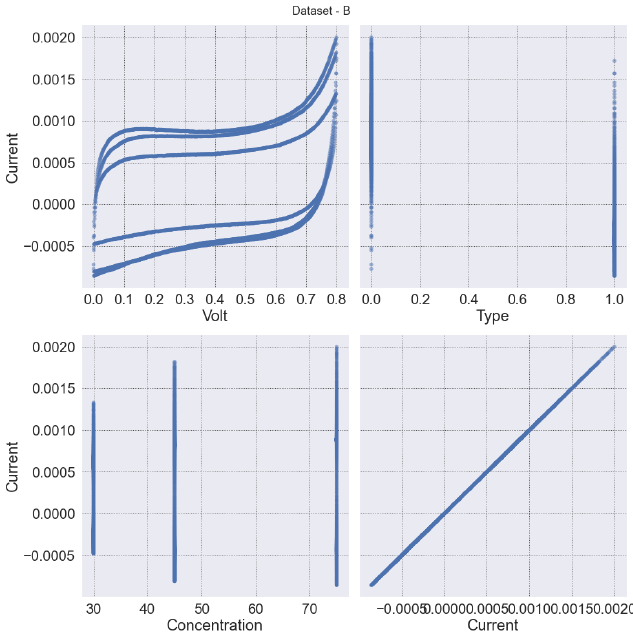
Figure 9. Scatter plots of Dataset B.